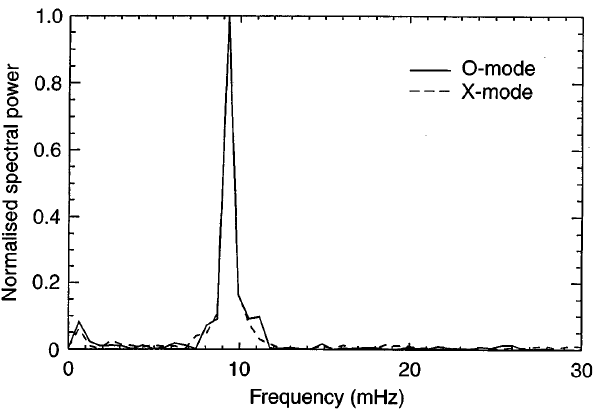
Fig. 2. Normalised power spectra of the Doppler O- and X-mode time series for the interval 0355-0422 UT on 2 September as displayed in